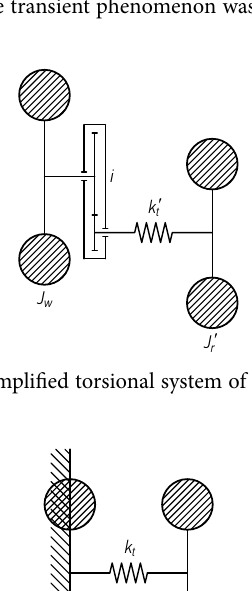
Fig. 4. The camera’s view of the observed wheel and ammeters in the driver’s cab recorded in the experiment numbered M03, at 10.06 s from the start of the test when the transient phenomenon was initiated